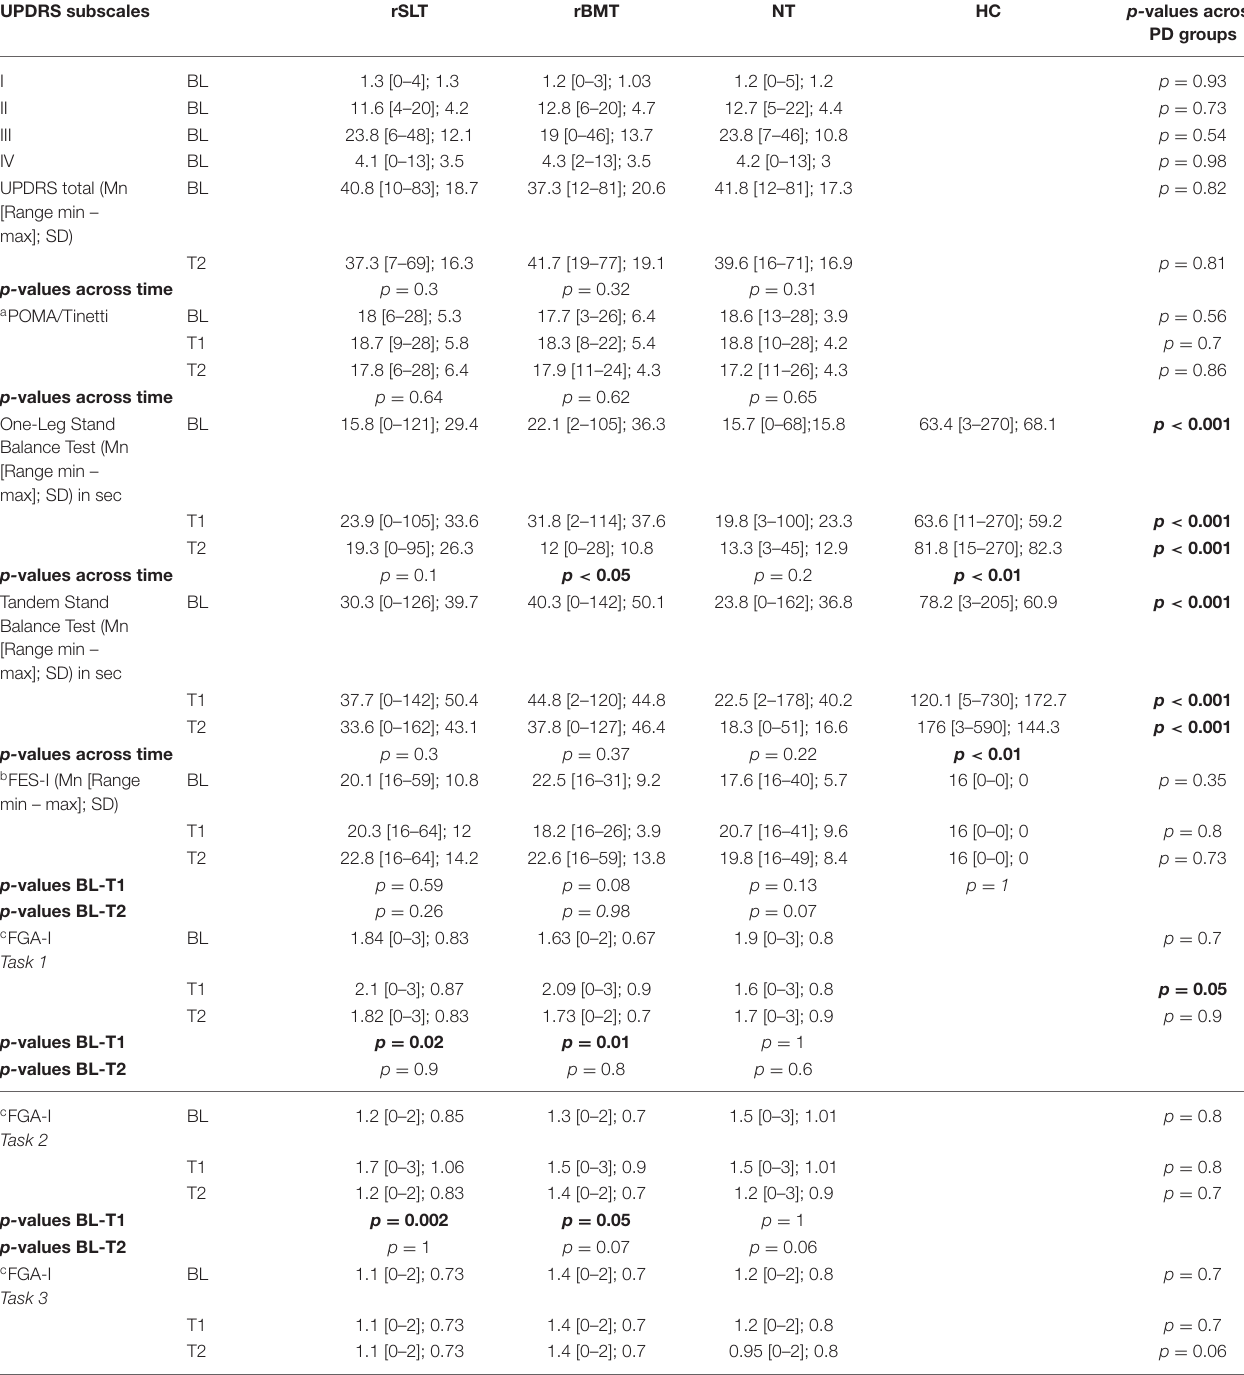
TABLE 1B | Motor and gait specific